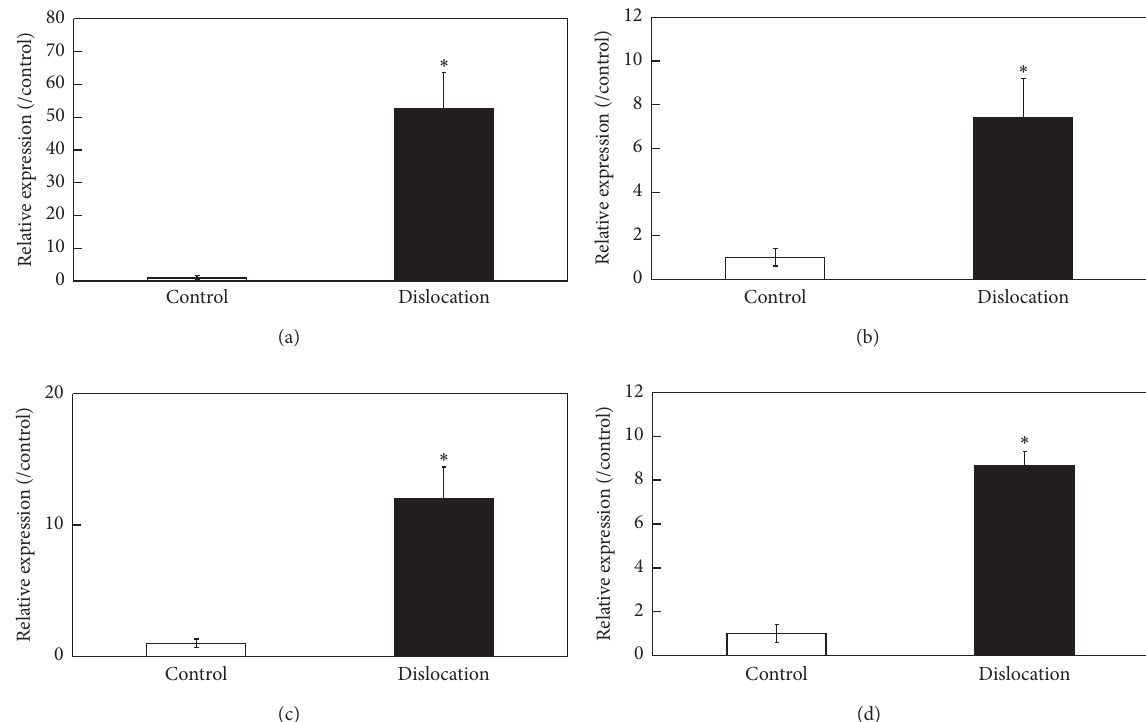
Figure 2: Real-time polymerase chain reaction (PCR) analysis of interleukin- (IL-) 1 𝛽 , adrenomedullin (AM), receptor activity-modifying protein 2 (RAMP2), and RAMP3 gene expression in the synovial tissue of C57BL/6J mice. (a) IL-1 𝛽 , (b) adrenomedullin (AM) , (c) receptor activity-modifying protein 2 (RAMP2) , and (d) RAMP3 gene expression in ST obtained from the control and dislocated side of a patellar surgical dislocation model generated in C57BL/6J mice. ∗ Statistically significant difference between the control and dislocated side. All data are presented as the mean ± standard error ( 𝑛 = 5